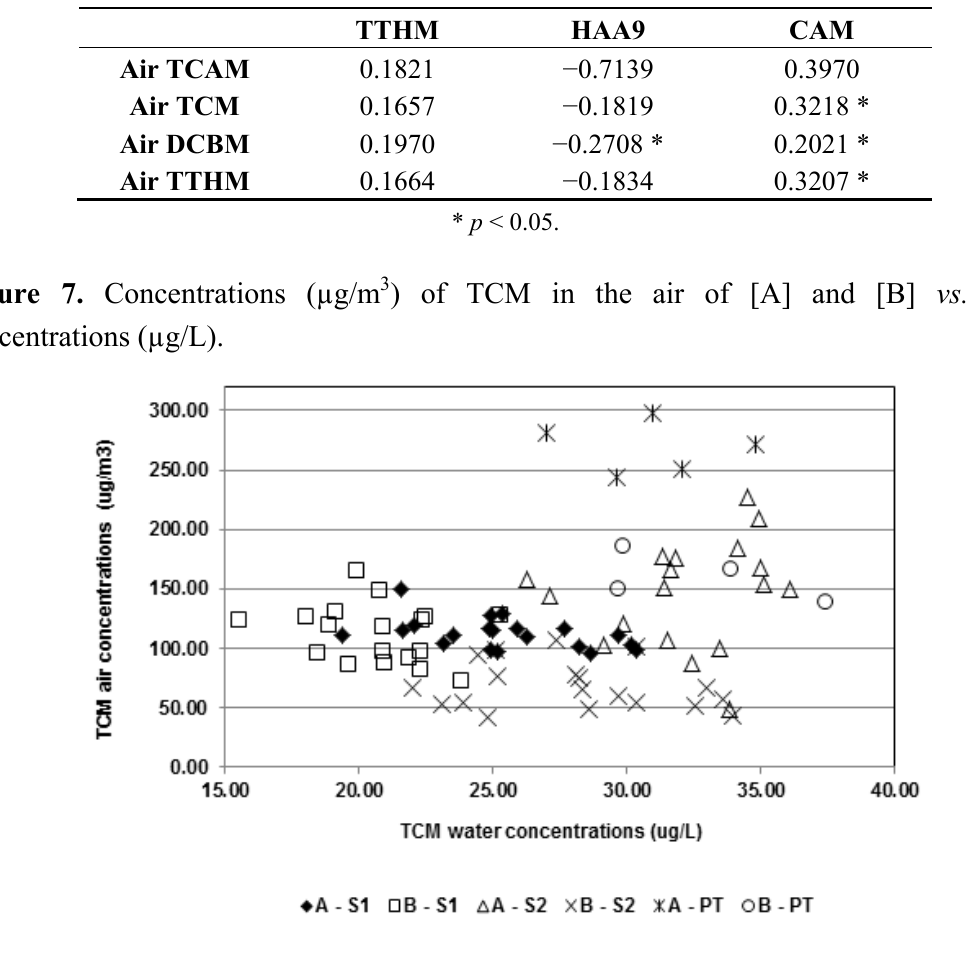
Table 6. Pearson coefficient of correlations between DBP concentrations in water and DBP concentrations in air overall sessions and pools.